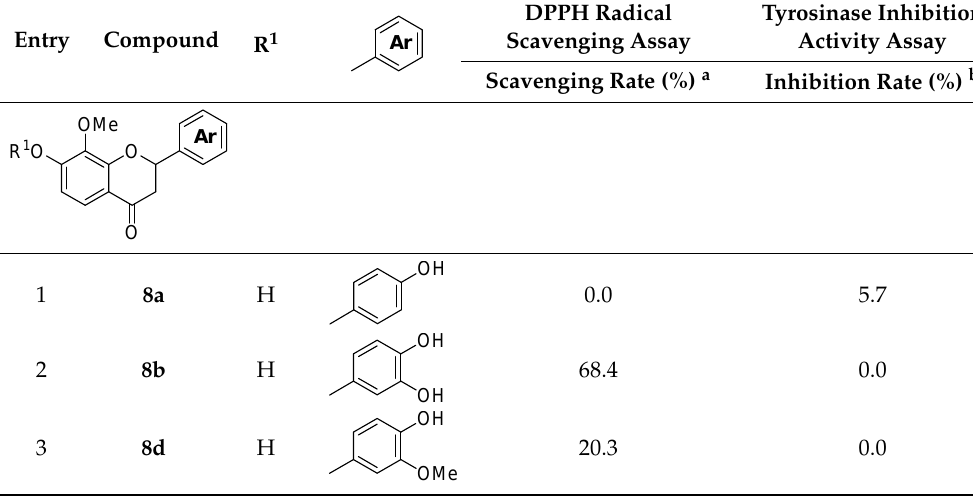
Molecules 2018 , 23 , x FOR PEER REVIEW Table 2. The DPPH radical scavenging assay and tyrosinase inhibition activity assay of flavanones Table 2. The DPPH radical scavenging assay and tyrosinase inhibition activity assay of flavanones Table 2. The DPPH radical scavenging assay and tyrosinase inhibition activity assay of flavanones Table 2. The DPPH radical scavenging assay and tyrosinase inhibition activity assay of flavanones 8a – 8a – l. 8a – l. Table 2. The DPPH radical scavenging assay and tyrosinase inhibition activity assay of flavanones 8a – l. Table 2. The DPPH radical scavenging assay and tyrosinase inhibition activity assay of flavanones 8a – l. 8a – l. Entry Compound R 1